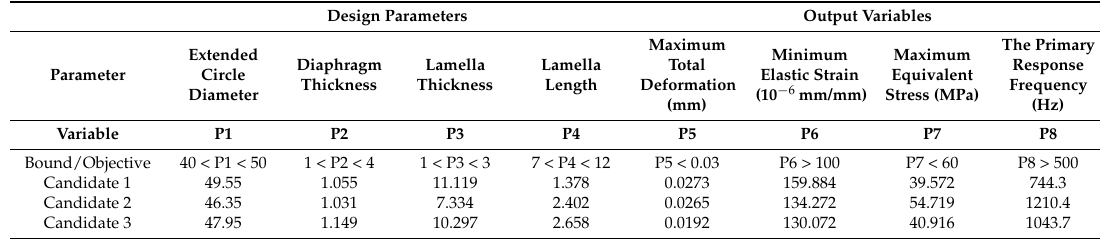
Table 2. Design parameters and output